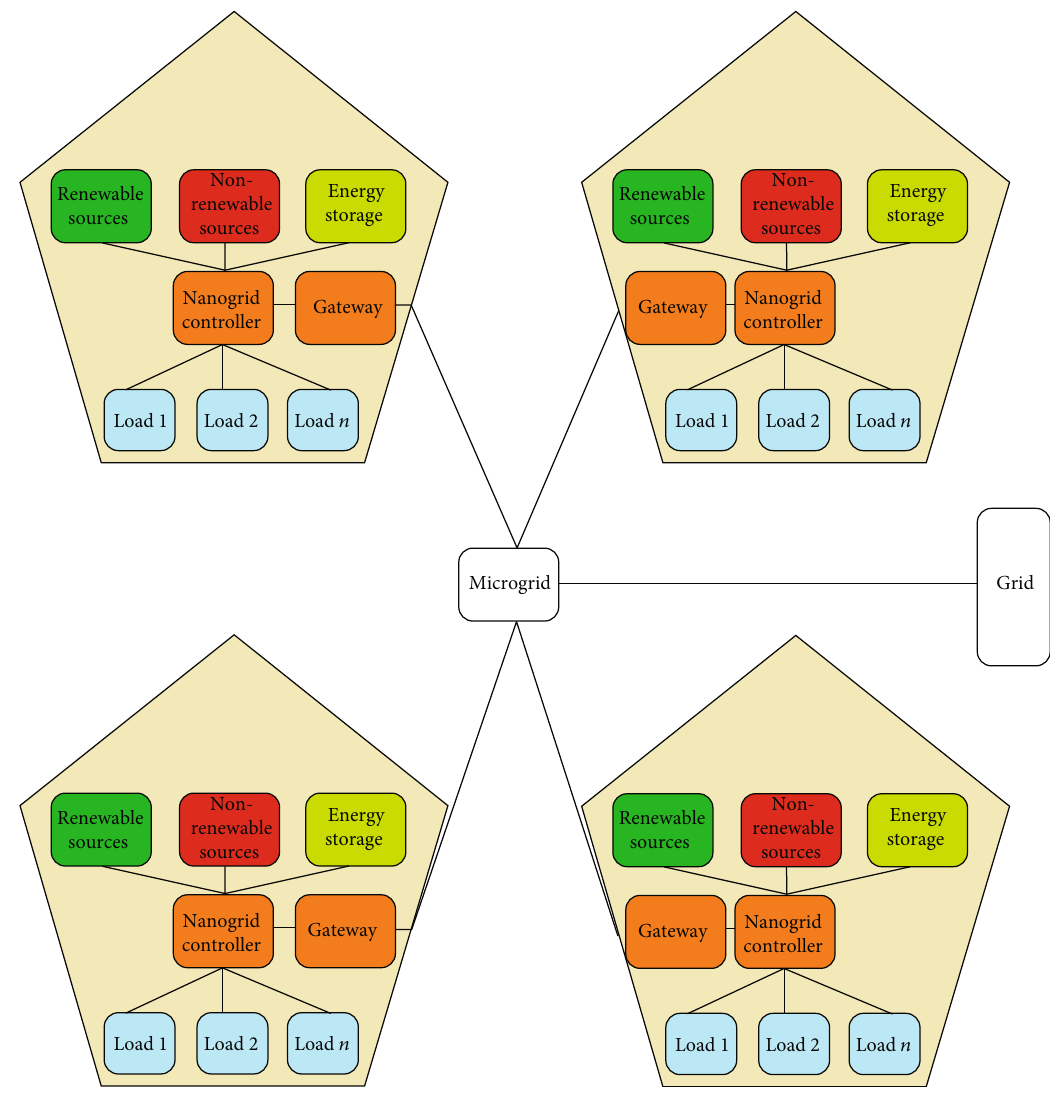
Figure 9: Multiple nanogrids form microgrid.